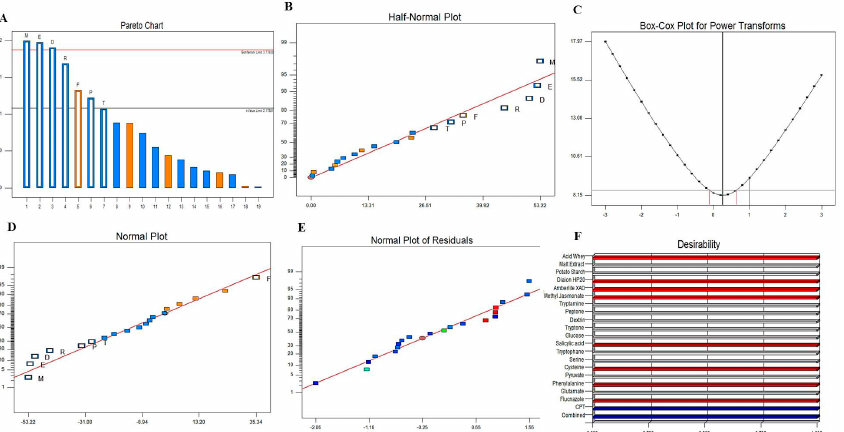
Figure 5. The main effects of different variables on camptothecin production according to the Plackett-Burman experimental design. The normal probability plots of the variables for camptothecin production by P. chrysogenum as determined by the first order polynomial equation. ( A ) Pareto chart illustrates the order of significance of each variable. ( B ) Plot of correlation between predicted and actual camptothecin yield of P. chrysogenum . ( C ), Box-Cox power transform. ( D ) Plot of standardized effect with normal probability. Plot of standardized effect with normal residuals ( E ) and desirability ( F ).